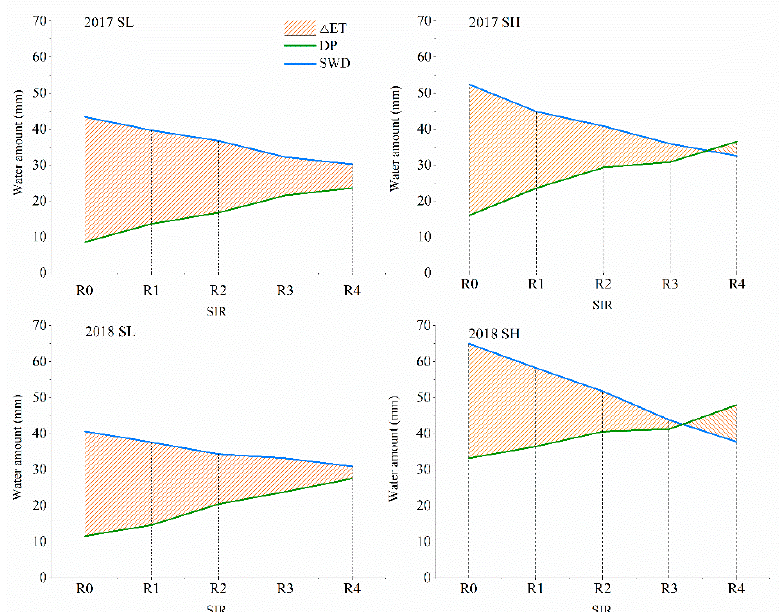
Figure 3. Effect of irrigation water salinity (IWS) and straw incorporation rate (SIR) on soil water depletion (SWD), deep percolation (DP), and the variation of evapotranspiration ( △ ET). △ ET refers to the deviation of SWD and DP. Note: R0, R1, R2, R3, and R4 indicate the straw incorporation rates of 0, 4.5, 9.0, 13.5, and 18.0 t ha − 1 , respectively; SL indicates the low salinity water (1.92 dS m − 1 ); SH indicates the high salinity water (3.20 dS m − 1